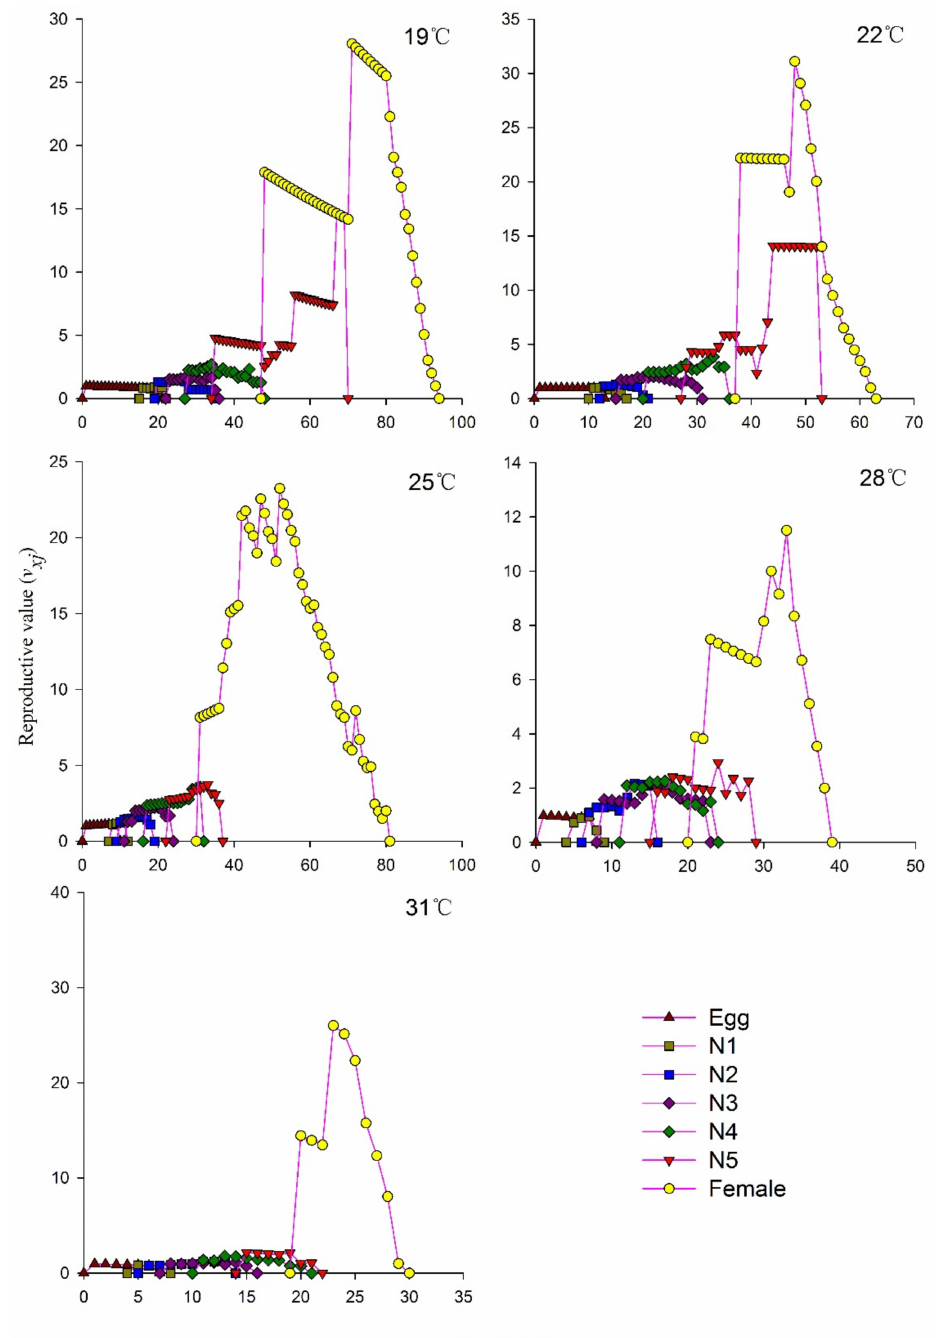
Figure 5. Reproductive value ( v xj ) of each age–stage group of Riptortus pedestris at different tempera- tures. Note: N1–N5 represents first, second, third, fourth, and fifth instar,